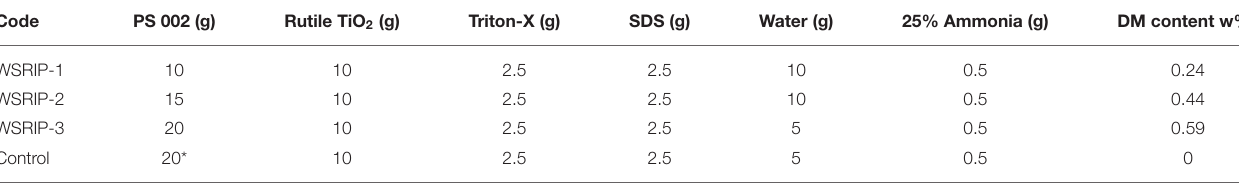
TABLE 3 | Composition of paint formulations developed in the study.